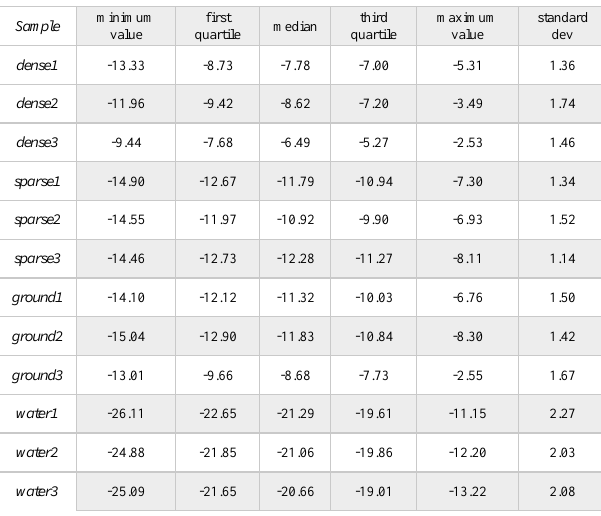
Figure 8. VV backscatter values of the samples (dB), from the boxplot in Figure